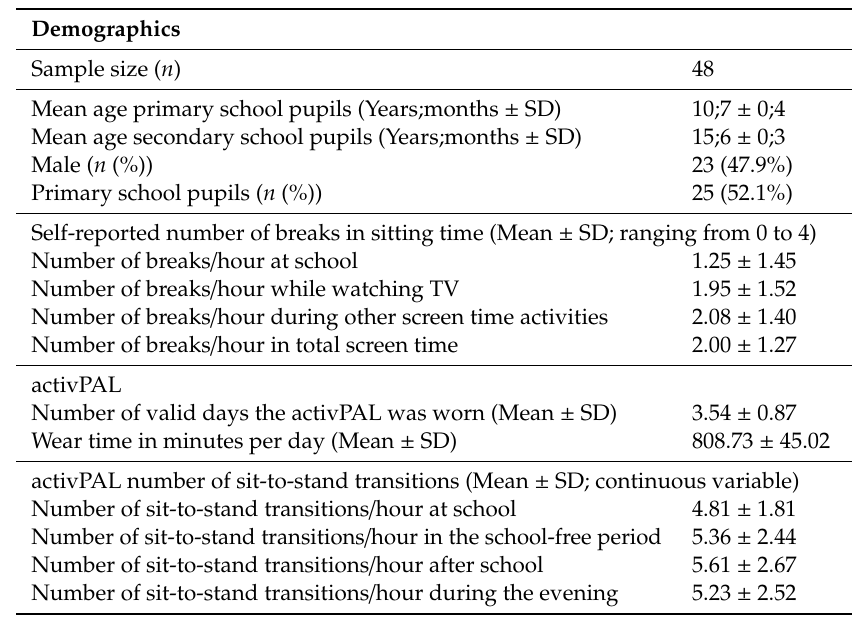
Table 2. Characteristics of participants with valid